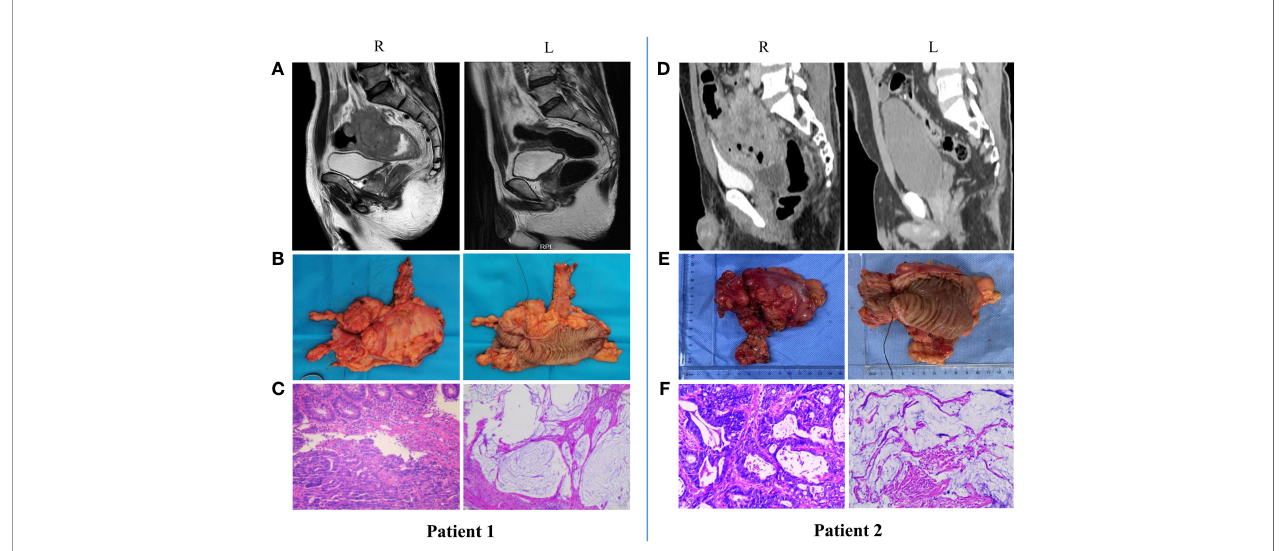
FIGURE 2 | Radiologicand pathological response to nIT with Tislelizumab,and surgical specimens in two patients with MSI-H/dMMR LACRC (pCR). (A, D) Imaging: Pretreatment (R) VS After 6 cycles of nIT (L); (B, E) Surgical specimens: After 6 cycles of nIT (R/L); (C,F) Pathology: Pretreatment (R)VS After 6 cycles of nIT (L).